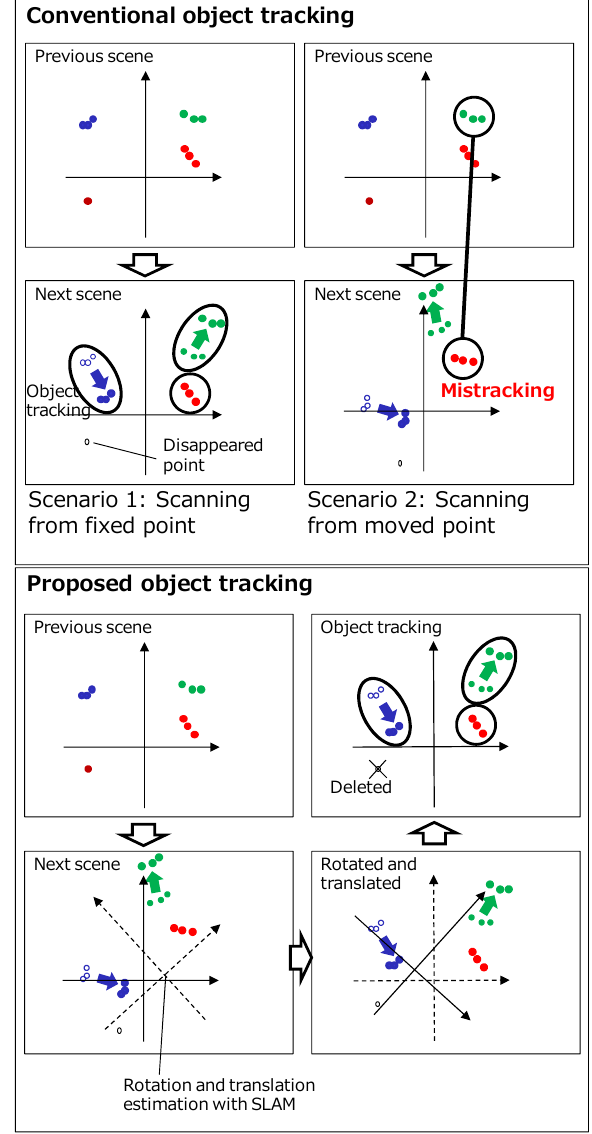
Figure 4. Moving object tracking and